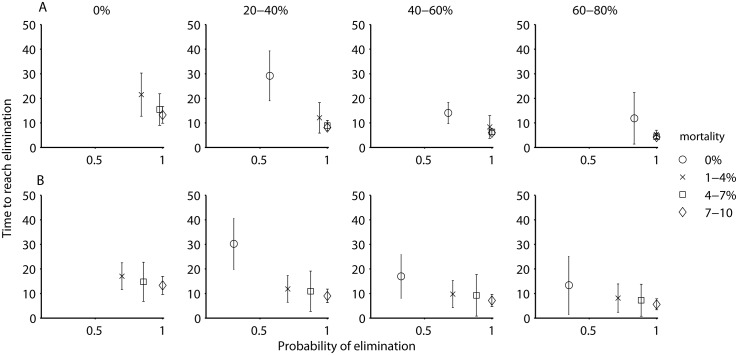
The proportion of simulations where HAT was eliminated (i.e., prevalence < 1 x 10−6) and the mean time to elimination, depending on the percentage of the human population screened per year, with varying levels of vector control (expressed as additional vector mortality, indicated by the symbols in the legend), for a moderate transmission setting without an animal reservoir (A) and with an animal reservoir (B).